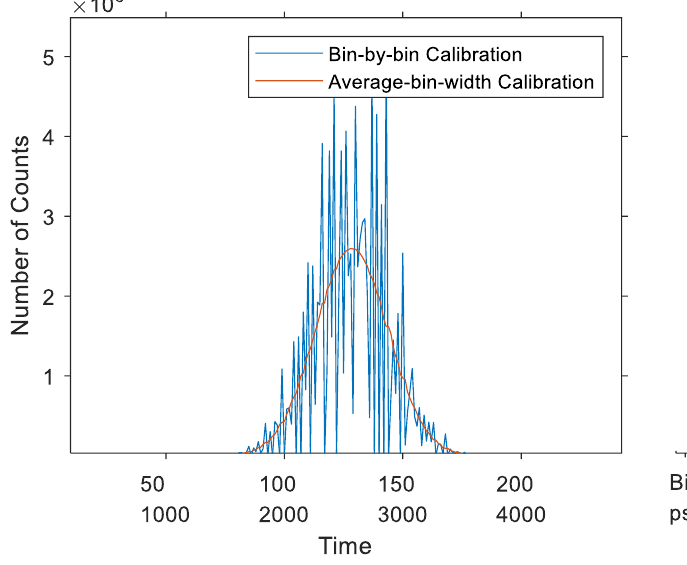
Figure 14. Calibrated histogram of a Gaussian signal — synchronous TDCs.